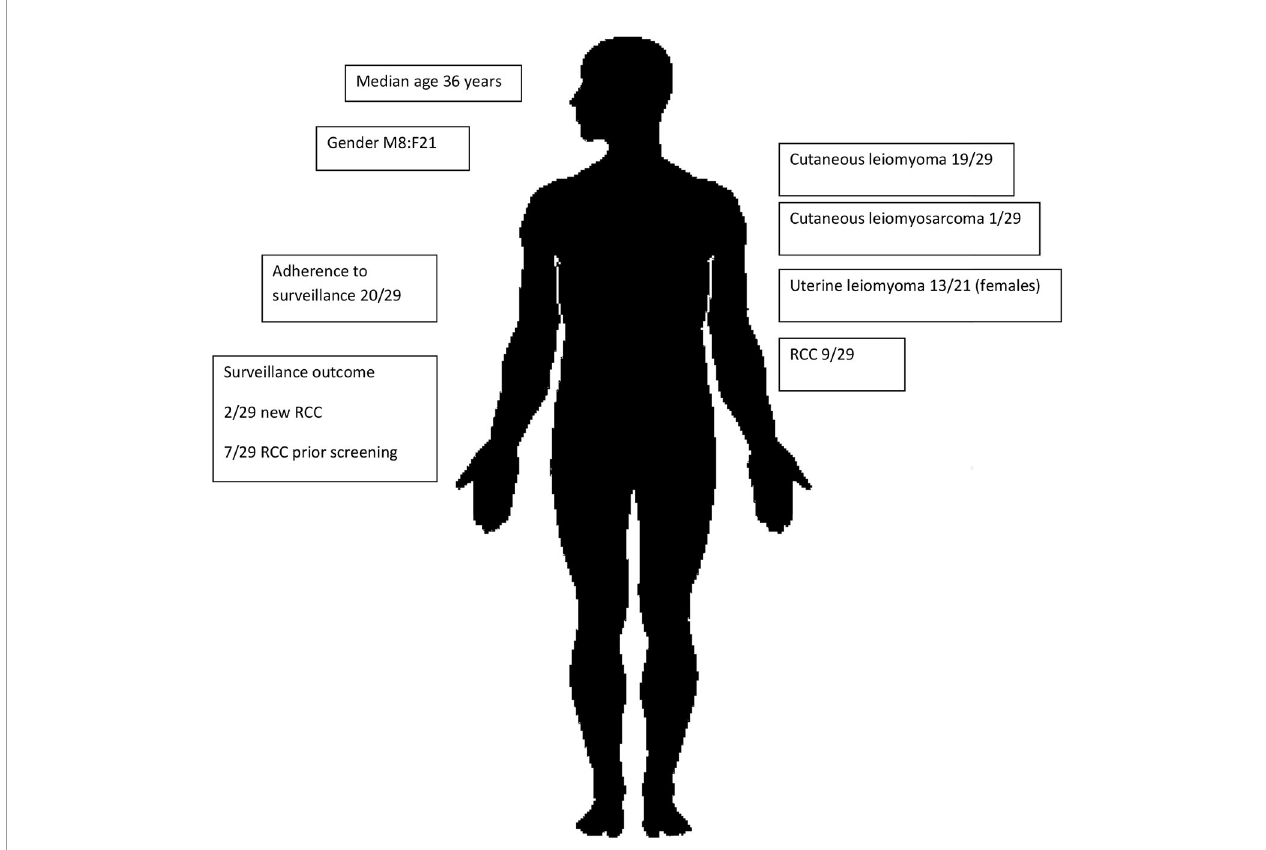
FIGURE 2 | HLRCC subcohort